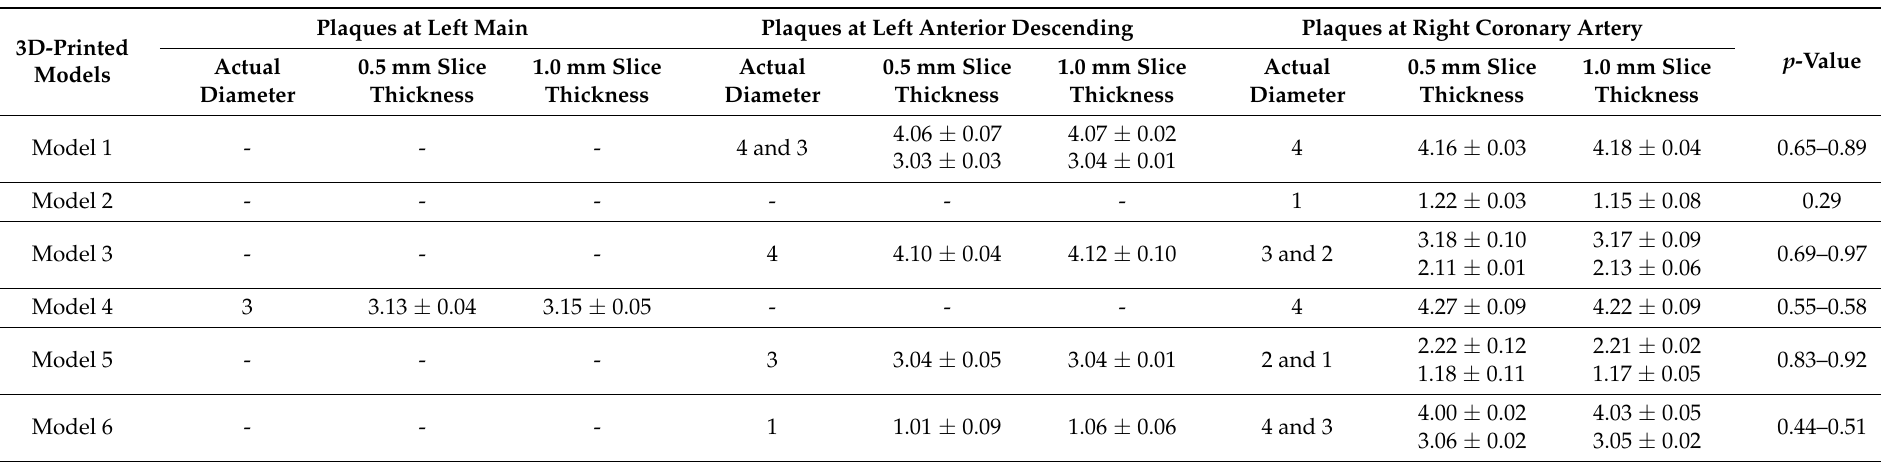
Table 2. Comparison of plaque diameter measurements between CT protocols using 0.5 mm and 1.0 mm slice